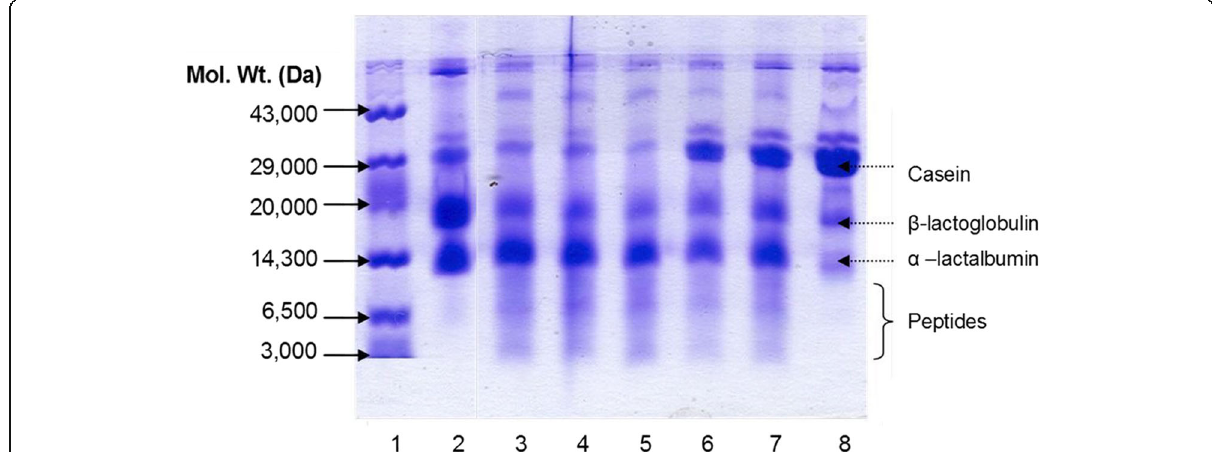
Fig. 3 Tricine SDS-PAGE of WPC, hydrolyzate, toned and enriched milk samples after different treatments. Lane 1 - Standard; lane 2 - whole WPC; lane 3, 4, 5 – hydrolyzate, boiled, freeze dried hydrolyzate, respectively; lane 6 -freeze dried enriched milk; lane 7 - enriched milk; lane 8 - toned